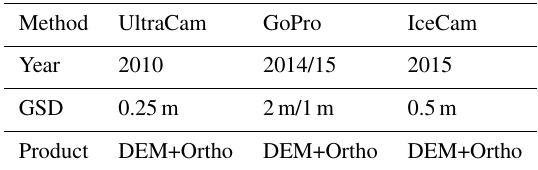
Table 2. Characteristic of the